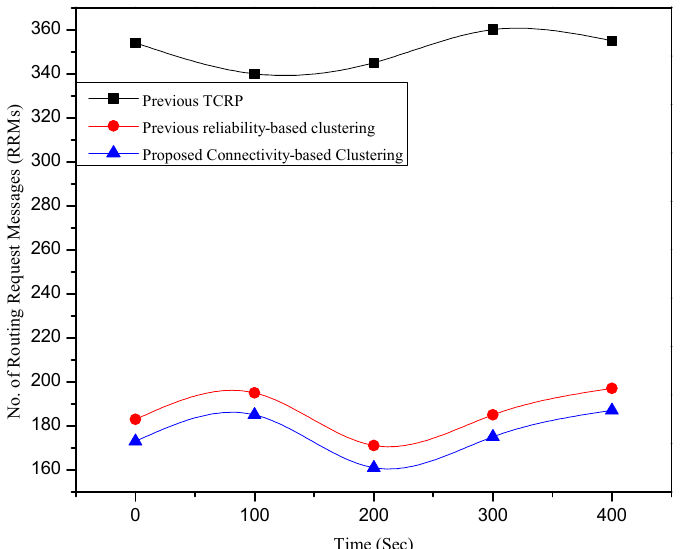
Figure 3. Comparison of our suggested connectivity-based clustering overhead/route request messages (RRMs) with the previous reliability-based clustering [3] and triple cluster-based routing protocol (TCRP) [1].